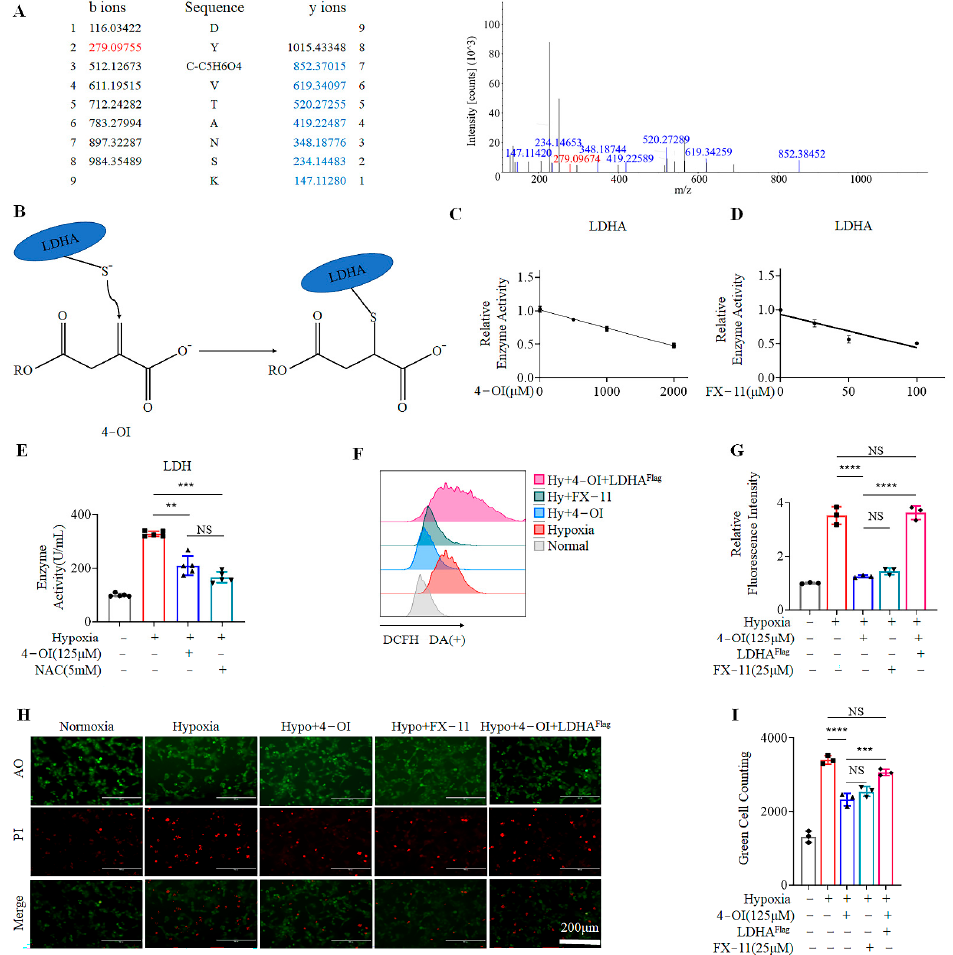
Figure 3. Treatment with 4-OI impairs ROS generation by modifying LDHA, and inhibits LDH activity to minimize hypoxia damage: ( A ) Mass spectrometry analysis used to identify the alkylation of LDHA caused by 4-OI. ( B ) Schematic diagram of the GAPDH thiol group covalently modified by 4-OI. ( C , D ) Enzymatic activity results for LDHA treated with 4-OI or FX-11. ( E ) The LDH enzyme activity of MIN6 cells after treatments was measured. ( F , G ) The levels of ROS and relative fluorescence intensity in MIN6 cells when treated with 125 μΜ 4-OI, 25 μΜ FX-11, or overexpression of LDHA Flag , was assessed by FACS ( F ), and their quantification ( G ). ( H , I ) Survival rates of MIN6 cells cultured under hypoxia for 72 h examined by AO/PI staining ( H ), and their counts of green-stained cell ( I ). Error bars represent the mean ± SD. One-way ANOVA was performed with ** p < 0.005, *** p < 0.0005, **** p < 0.00005, NS: non-significant.